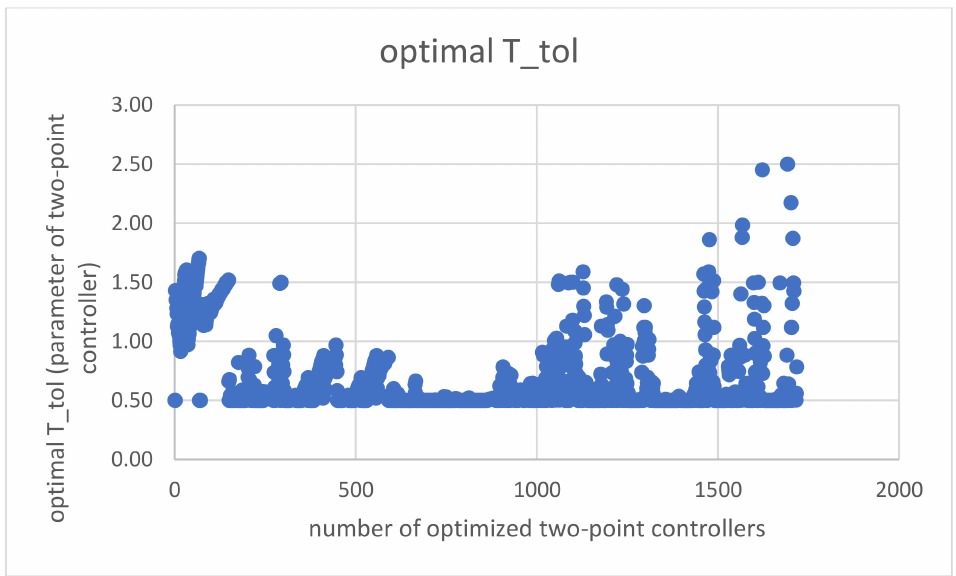
Figure 10. Optimal controller parameter T_tol of two-point controller (Supplementary Materials).